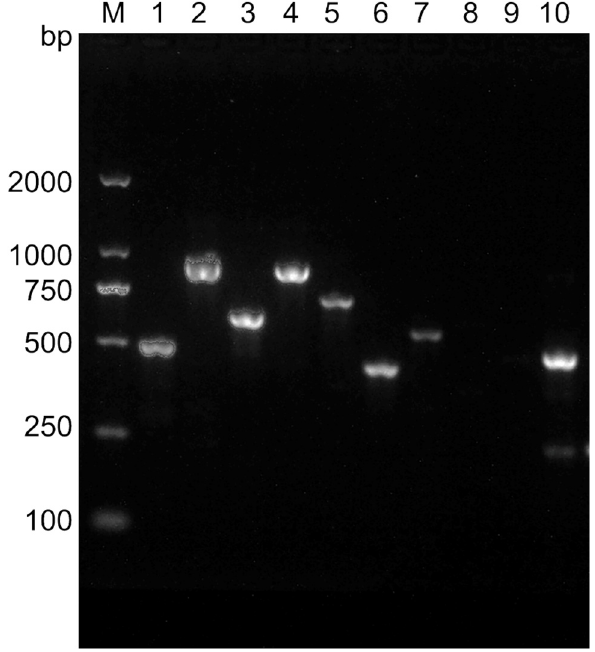
Figure 2. Gel electrophoretogram of virulence factor genes. Lane M represents the DL2000 DNA ladder marker. Lanes 1–10 represent NheA , NheB , NheC , HblA , HblC , HblD , bceT , cytK , ces , and entFM , respectively. Table 3. Raw data statistics and filtering.